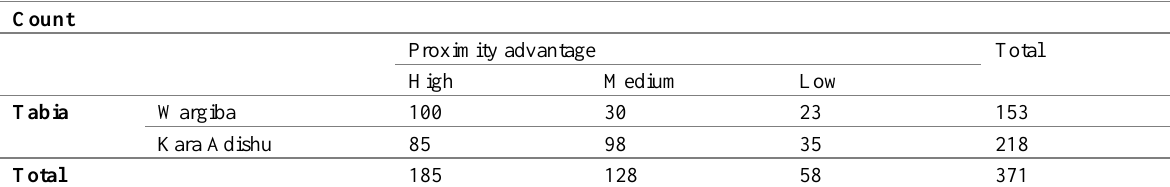
Table 3: Tibia * Proximity advantage Cross